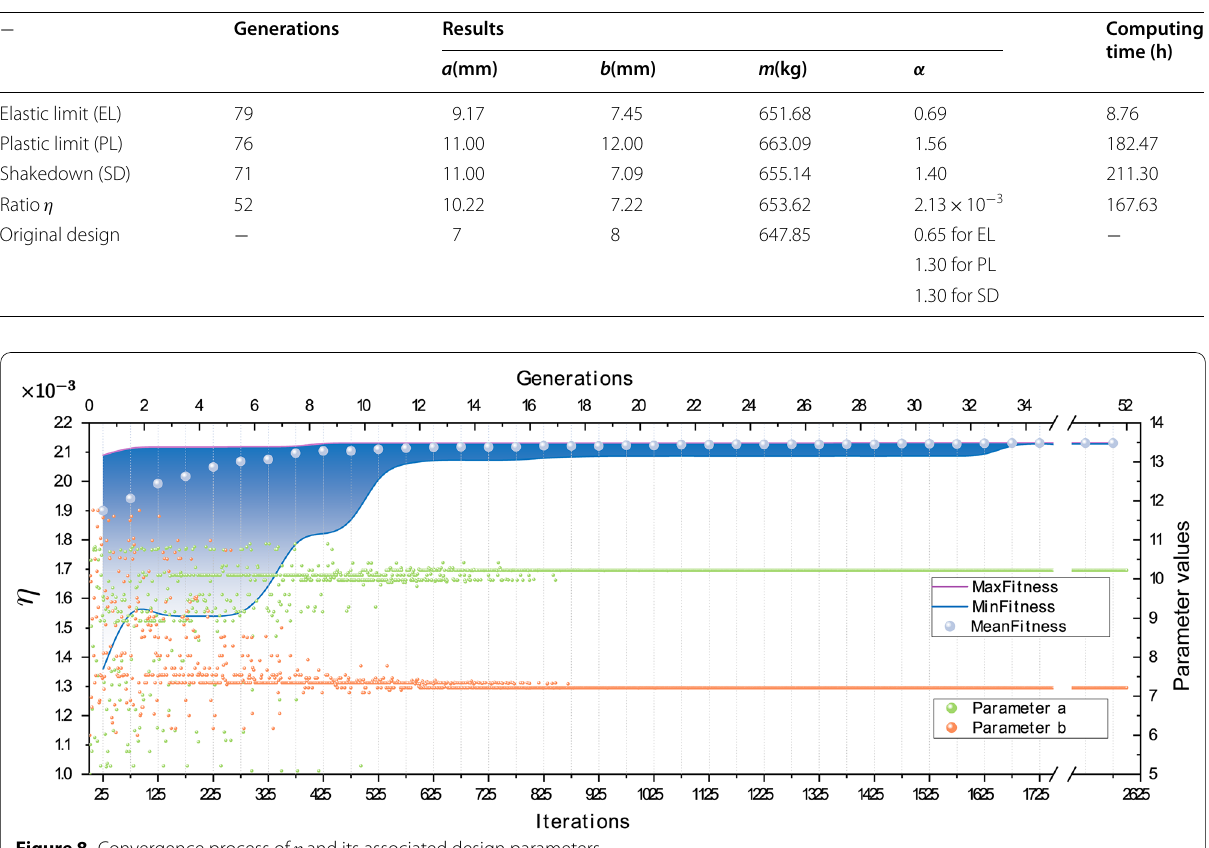
Figure 8 Convergence process of η and its associated design